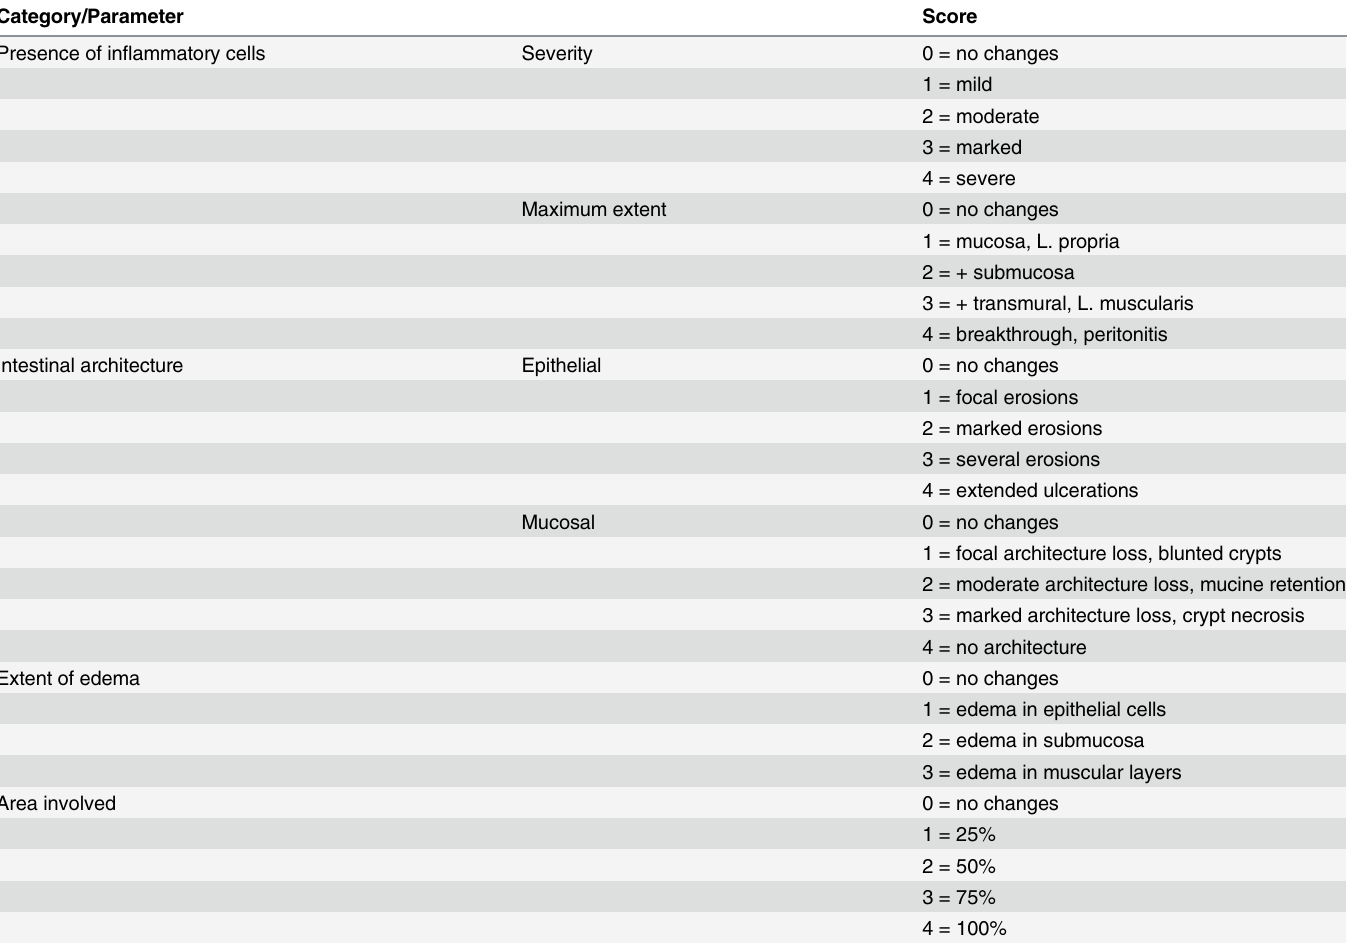
Table 2. Histology